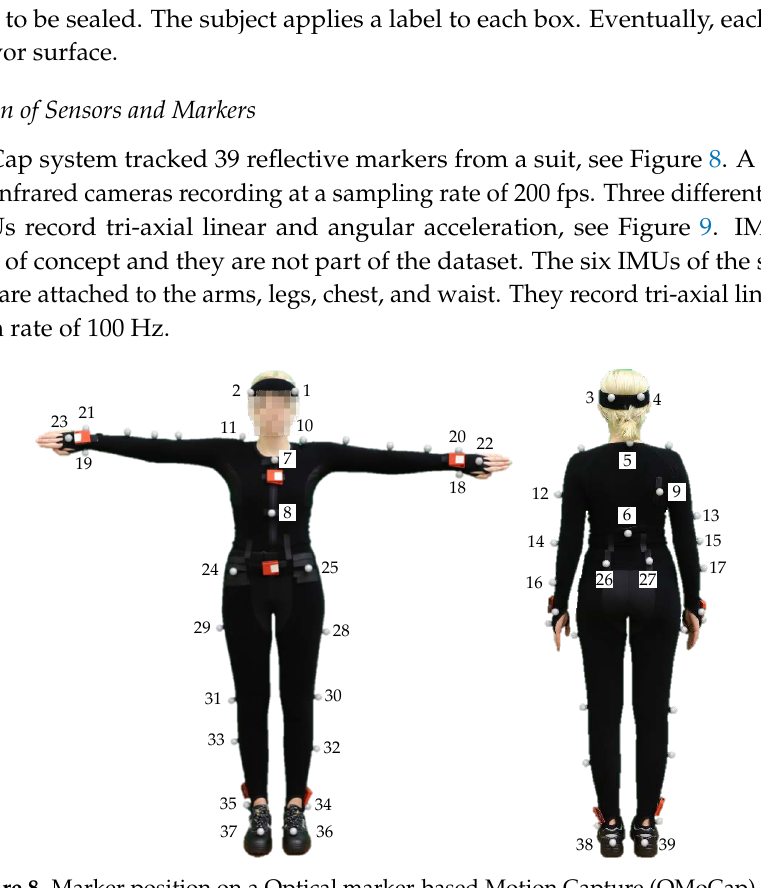
Figure 8. Marker position on a Optical marker-based Motion Capture (OMoCap) suit.